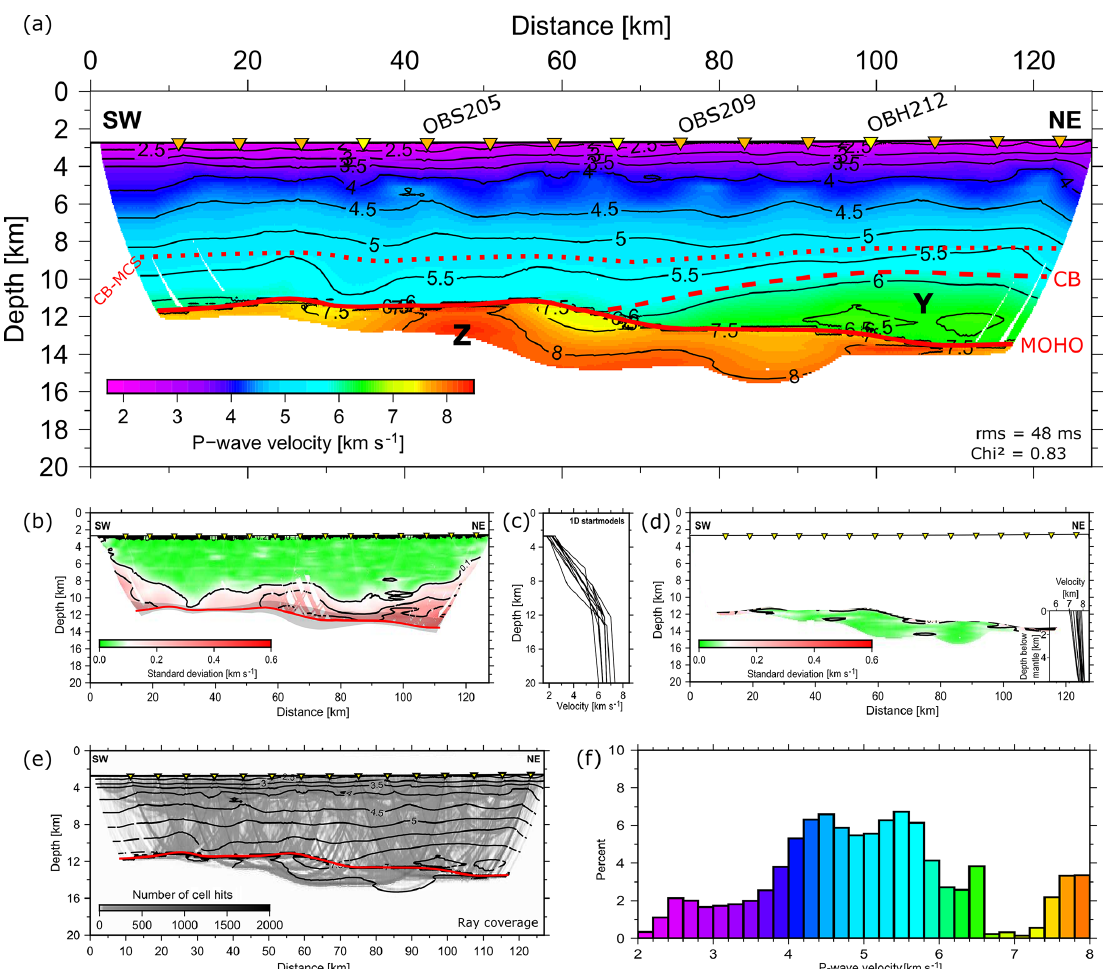
Figure 4. (a) Final velocity model based on the averaged velocities from the plausible starting models. The red dashed line marks the crystalline basement (CB) as determined from the refraction seismic data. The red dotted line presents the CB inferred from MCS data (CB- MCS) crossing our profile (details given in the text). The solid red line marks the crust–mantle boundary (Moho). (b) Standard deviation for 17 inverted velocity models, covering the crustal part down to the Moho. (c) Starting models used in the inversion and to calculate the resulting average model in (a) . (d) Standard deviation for 14 inverted velocity models (starting models in the inlay), covering the upper mantle up to the Moho. (e) Ray coverage for the final average velocity model. (f) Histogram with the velocity distribution of the final average velocity